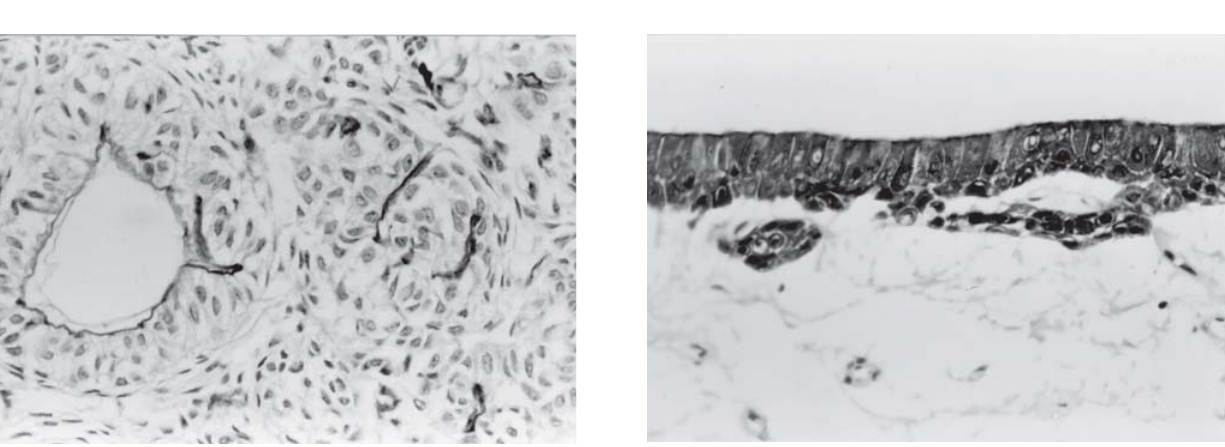
FIGURE 2- Adenomatoid odontogenic tumor: strong nuclear expression of PCNA restricted at solid areas (arrows), oppositing CK14 results. X400